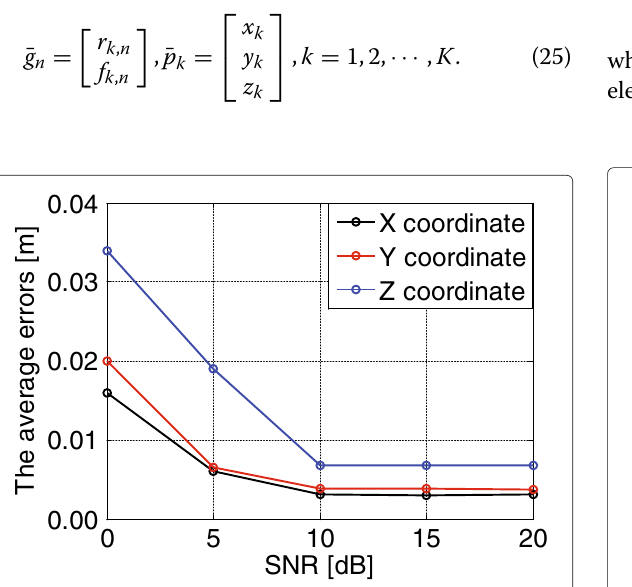
Fig. 7 Relationship between the SNRs and the average errors Fig. 8 CRLBs and estimated variance for the parameters ( x , y , z